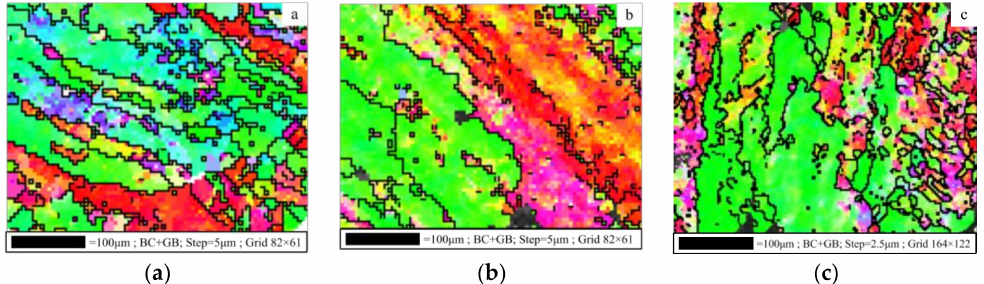
Figure 14. Microstructure of aluminum alloy 7050-T7451 in TD at different strain rates after impact shear: ( a ) 2.5 × 10 4 s − 1 ; ( b ) 3.5 × 10 4 s − 1 ; ( c ) 4.5 × 10 4 s − 1